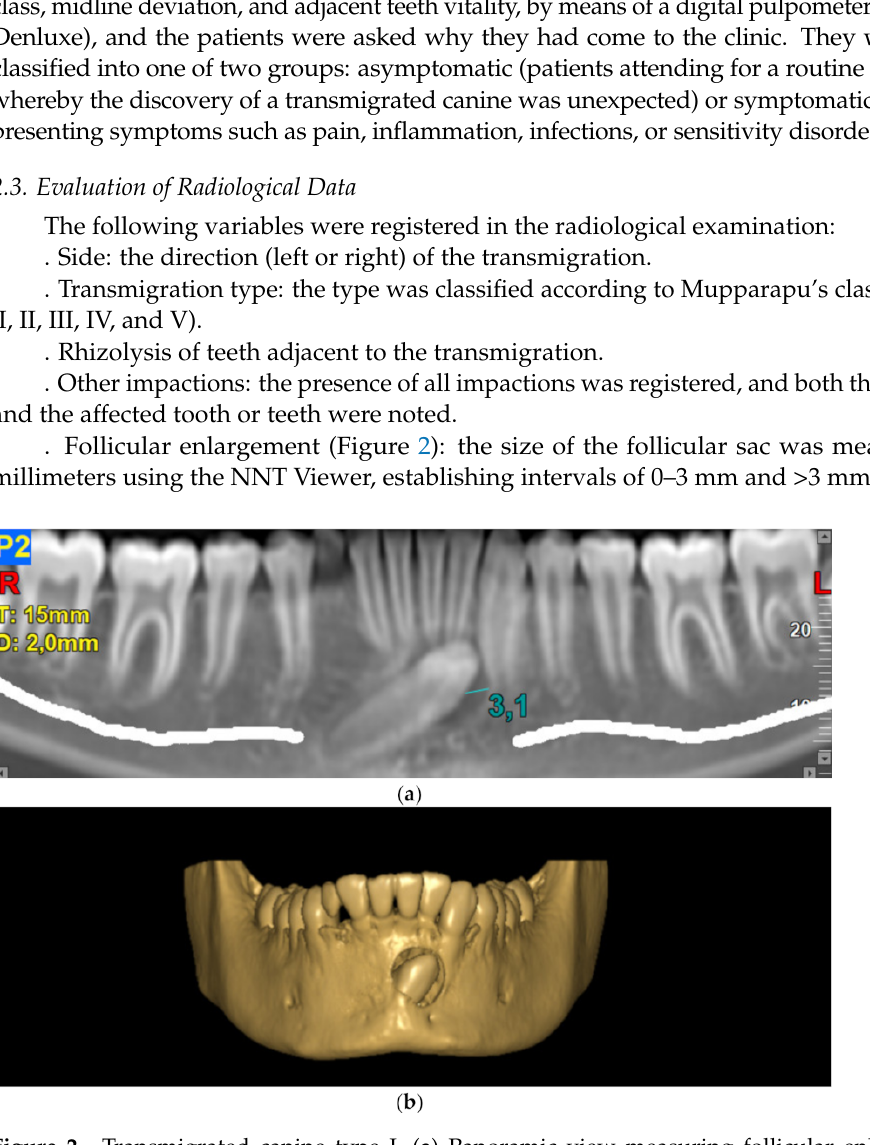
Figure 2. Transmigrated canine type I. ( a ) Panoramic view measuring follicular enlargement; ( b ) tridimensional